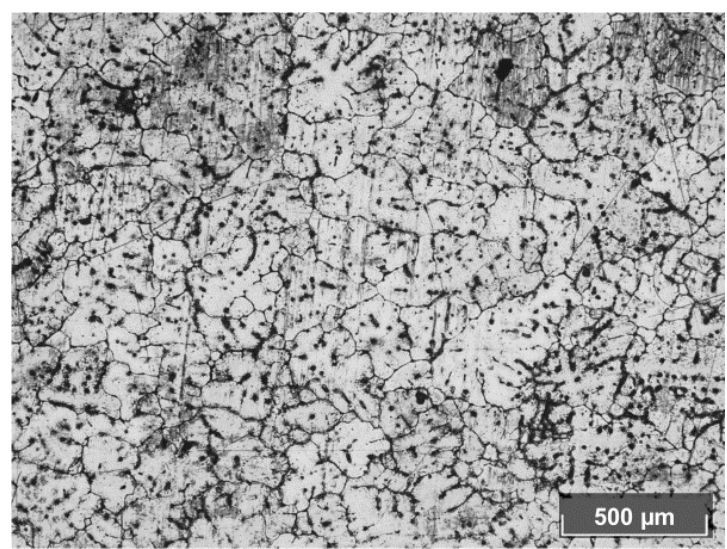
Figure 5. Annealed aluminum alloy billet structure (before piercing).